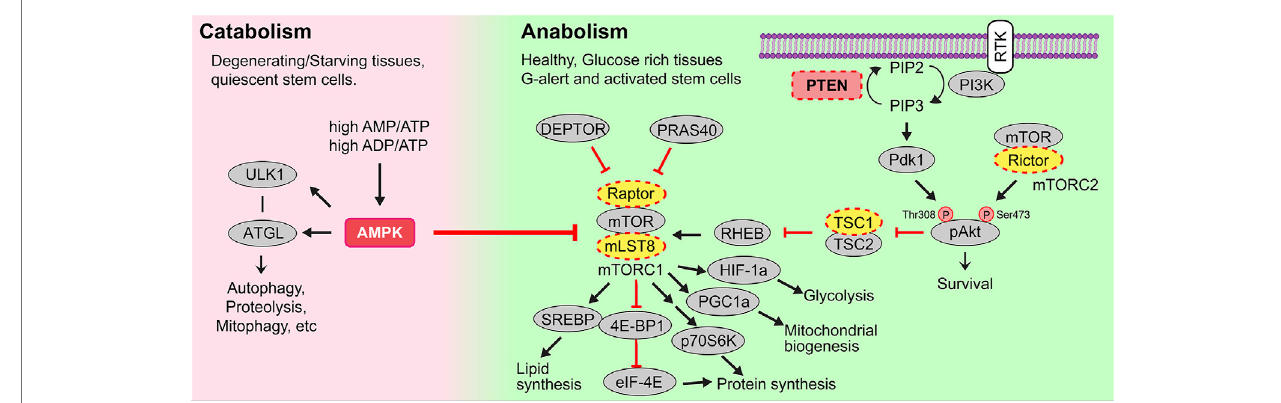
FIGURE 1 | Catabolic and anabolic pathways. Catabolic or energy consuming processes (e.g., autophagy, proteolysis, mitophagy, etc) are triggered by AMPK. AMPKisactivatedinconditionsofstarvationwhentherearehighAMP/ATPandADP/ATPratios,andindegeneratingtissuesorquiescentstemcells.Anabolicorenergy building processes (e.g., glycolysis, mitochondrial biogenesis, mitochondrial fi ssion, lipid synthesis) are controlled by growth factor signals, including those that bind receptor tyrosine kinases (RTK). Multiple downstream signals are activated by ligand-bound RTKs including the phosphoinositide-3-kinase (PI3K). PI3K activates